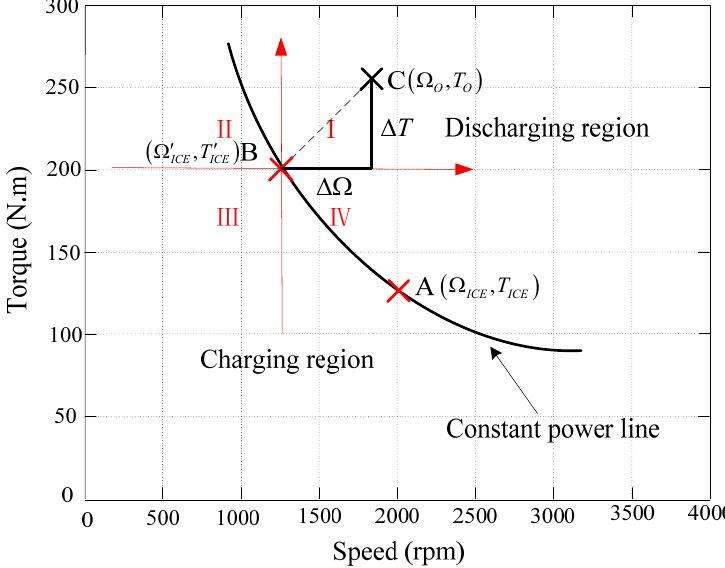
Figure 3. Energy transducing diagram of the flux-modulated